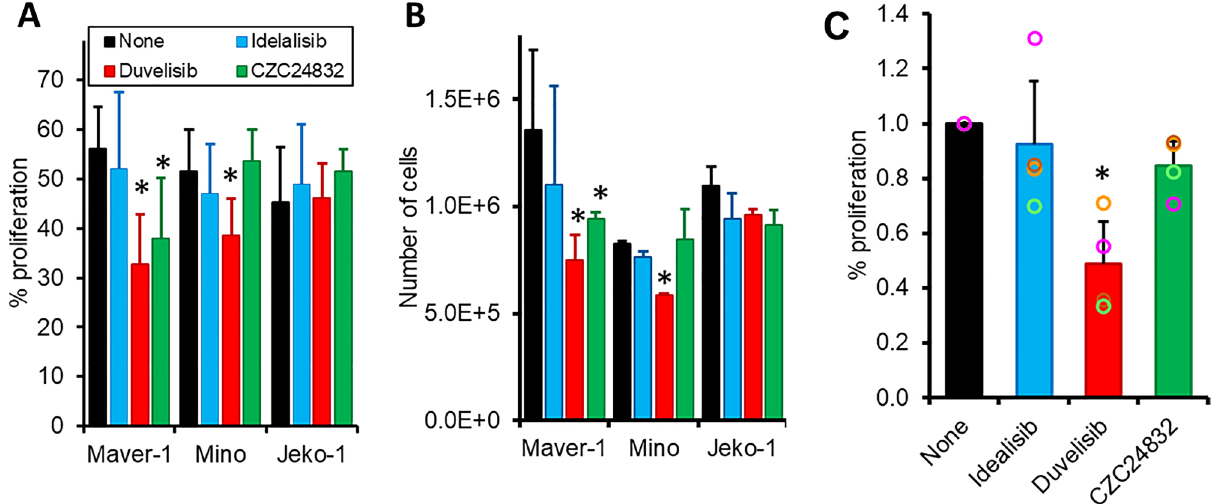
Figure 2. Inhibition of PI3Kγ reduces the proliferation of MCL cells. ( A , B ) Maver-1, Mino and Jeko-1 cells were incubated with 1 μM each of the indicated PI3K inhibitors or left untreated for 72 h. 5-ethynyl-2´- deoxyuridine (EdU) was added for the last 4 h of incubation. ( A ) The percentage of proliferating cells which had incorporated EdU into their DNA were determined by FACS analysis. ( B ) The number of cells were also counted manually at 72 h. ( A , B mean ± SD of 3 separate experiments). ( C ) PBMC from MCL patients were stained with CFSE and incubated for 14 d on HS-5 cells in the presence of IL-4; 1 μM each of the indicated PI3K inhibitors was added at the beginning of the culture period. CFSE is diluted proportionally by subsequent cell divisions, and this reduced fluorescence on divided cells was used to calculate the percentage of proliferating MCL cells. Since the levels of proliferation varied between the patients the data is normalised to the untreated control (raw data Supplementary Figure 3D); the bars represent the average proliferation (mean ± SD) and the circles the data for cells from each of the 4 patients studied. * P < 0.05. Statistical significance was determined using the paired Student’s T-Test; for ( C ) the test was performed on the raw